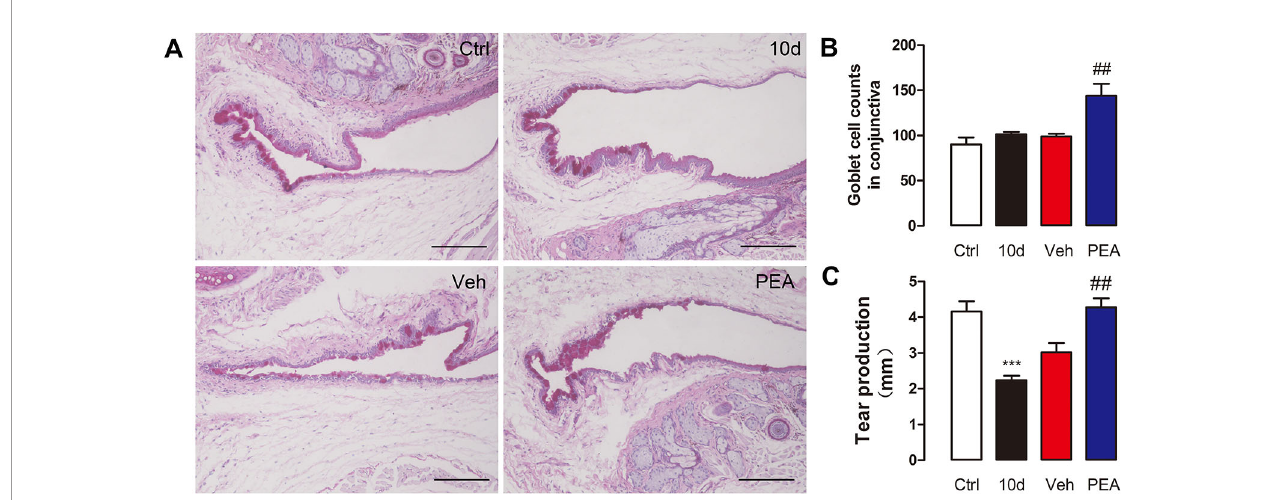
FIGURE 8 | PEA increased conjunctival goblet cells number and tear secretion. Representative images of PAS conjunctivae staining (A) , scale bars: 150 m m. Goblet cell density (B) and tear production (C) were expressed as mean ± SD in non-treatment control group (Ctrl), sleep deprivation (SD) for 10d group (10d), SD for 10d + solvent vehicle group (Veh), and SD for 10d + 30 mg/kg PEA treatment group (PEA). ***, P < 0.001 vs. control group; ## , P < 0.01 vs. vehicle group, one-way ANOVA followed by Dunette ’ s post hoc , n =